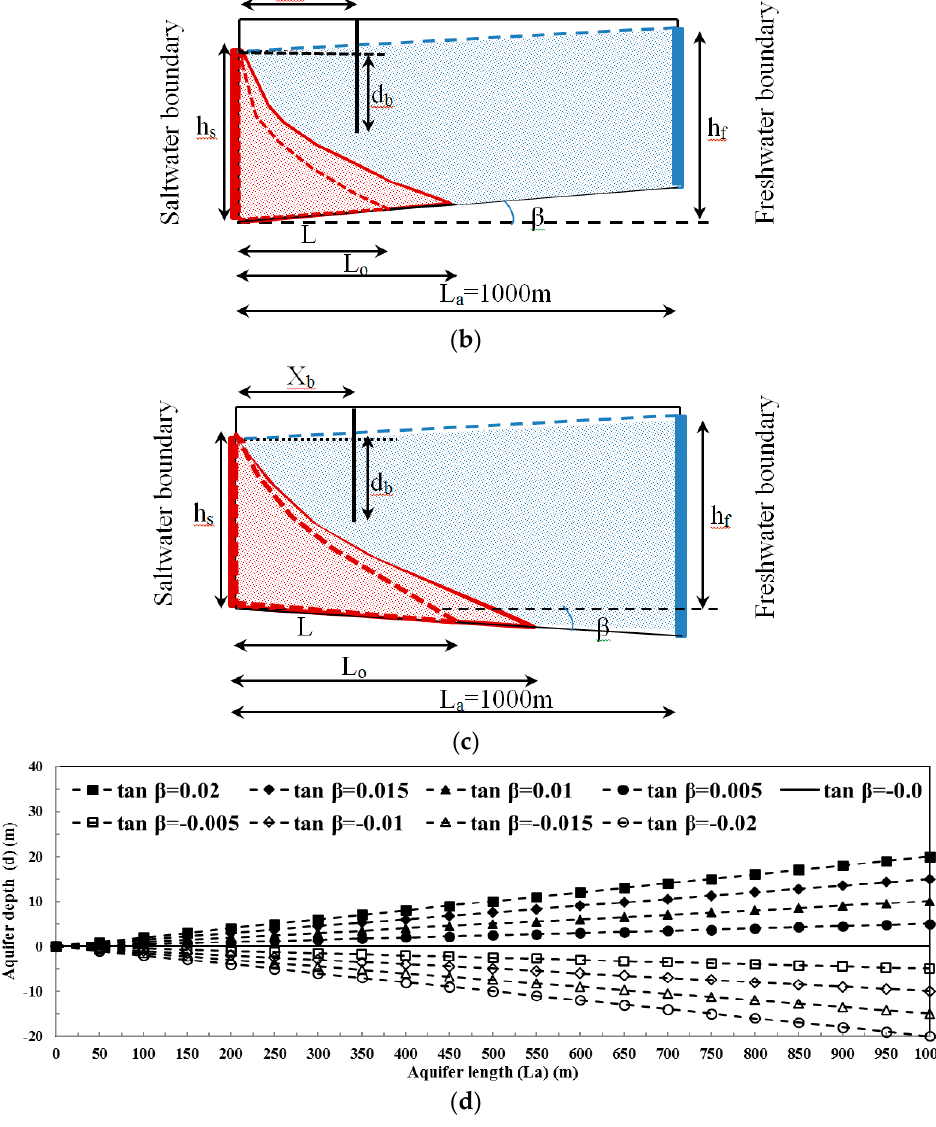
Figure 1. Dimensions and specifications of the hypothetical unconfined aquifer: ( a ) Horizontal aquifer; ( b ) positive sloping; ( c ) negative sloping; ( d ) sloping bed values of the unconfined aquifer. Table 2. Input parameters for numerical simulation of the flow